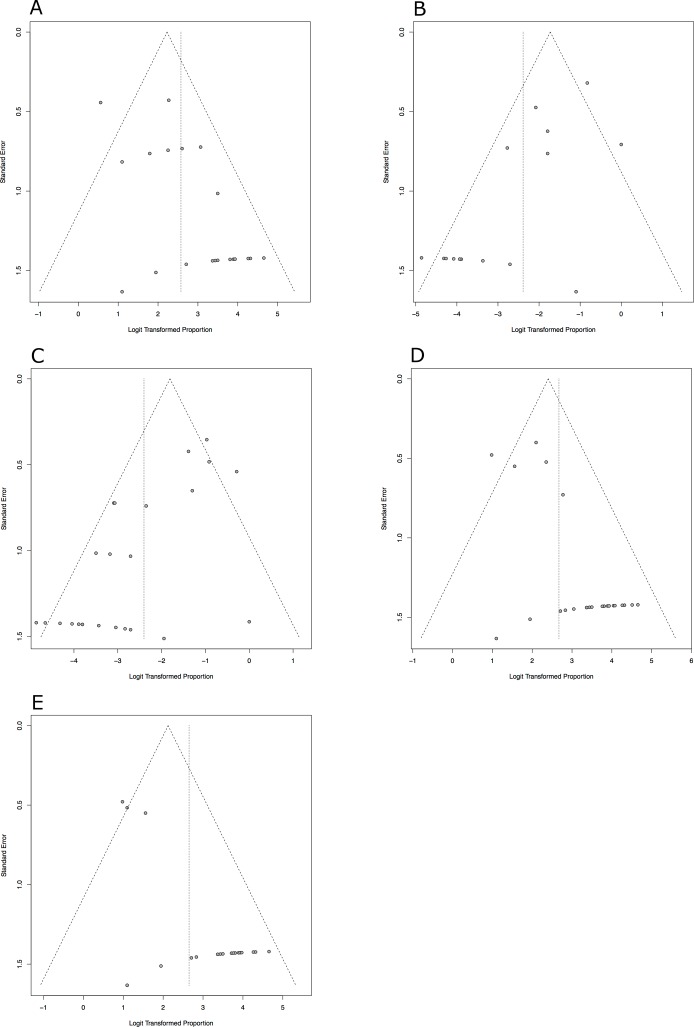
a-e
Funnel plots of the meta-analyses. (a) Radiological Outcome (b) Arm length discrepancy (c) Complication rate (d) Functional Outcome (e) Subgroup analysis of severly displaced fractures. A publication bias of the five meta-analyses could not be excluded.